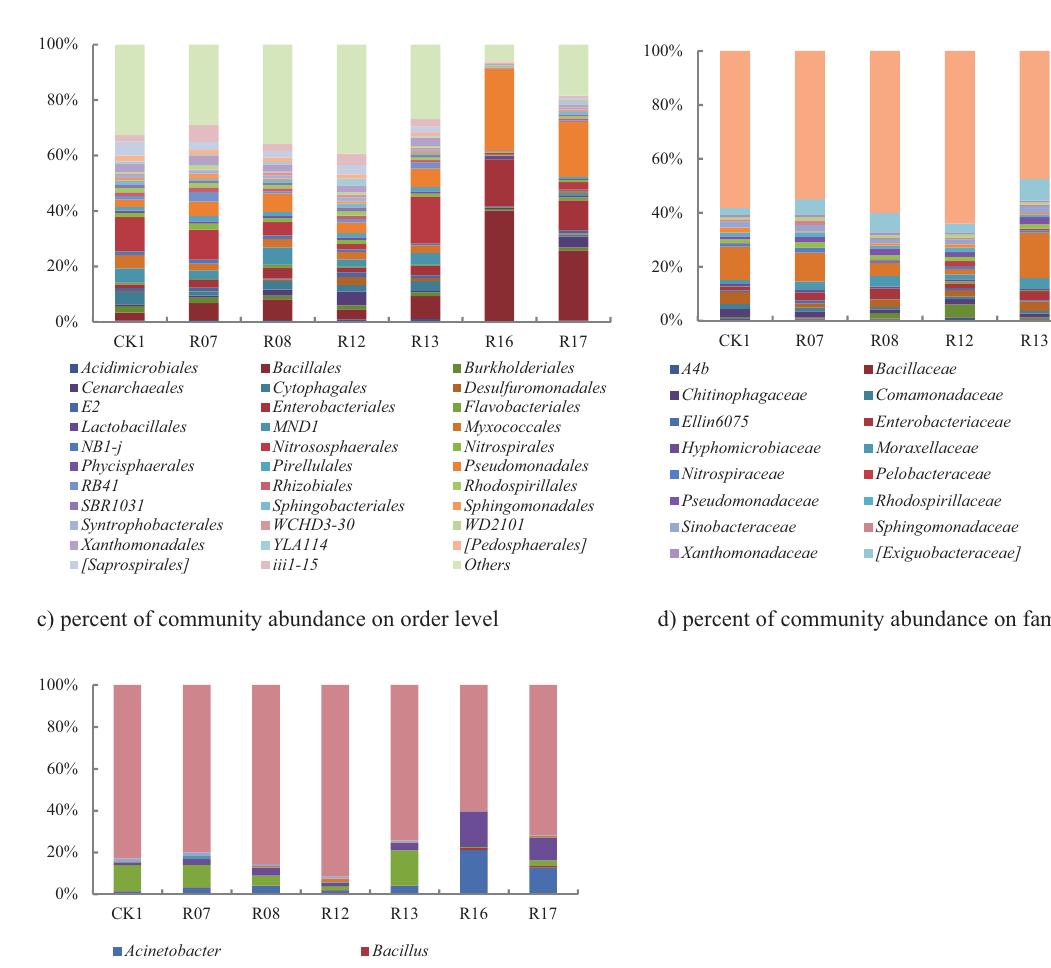
a) percent of community abundance on phyla level b) percent of community abundance on class